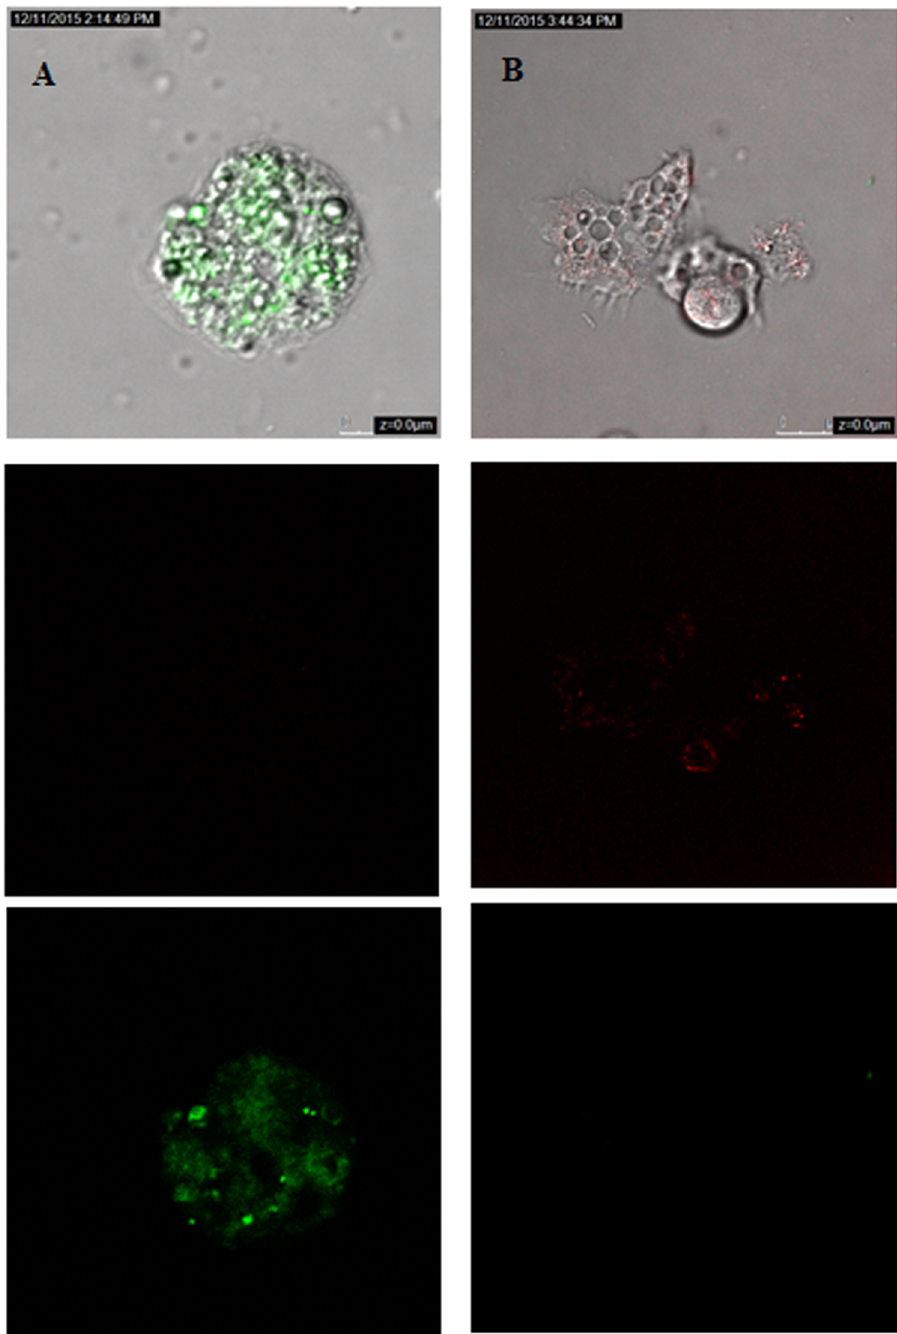
Figure 6. The effect of Systane Ultra on the mitochondrial potential, JC-1 dye accumulates in the mitochondria of healthy cells as aggregates (red fluorescence) (Negative control B); in cells treated with the IC 90 of Systane Ultra for 24 h, due to collapse of mitochondrial potential, the JC-1 dye remained in the cytoplasm in its monomeric form, green fluorescence. (Images are representative of the population of treated